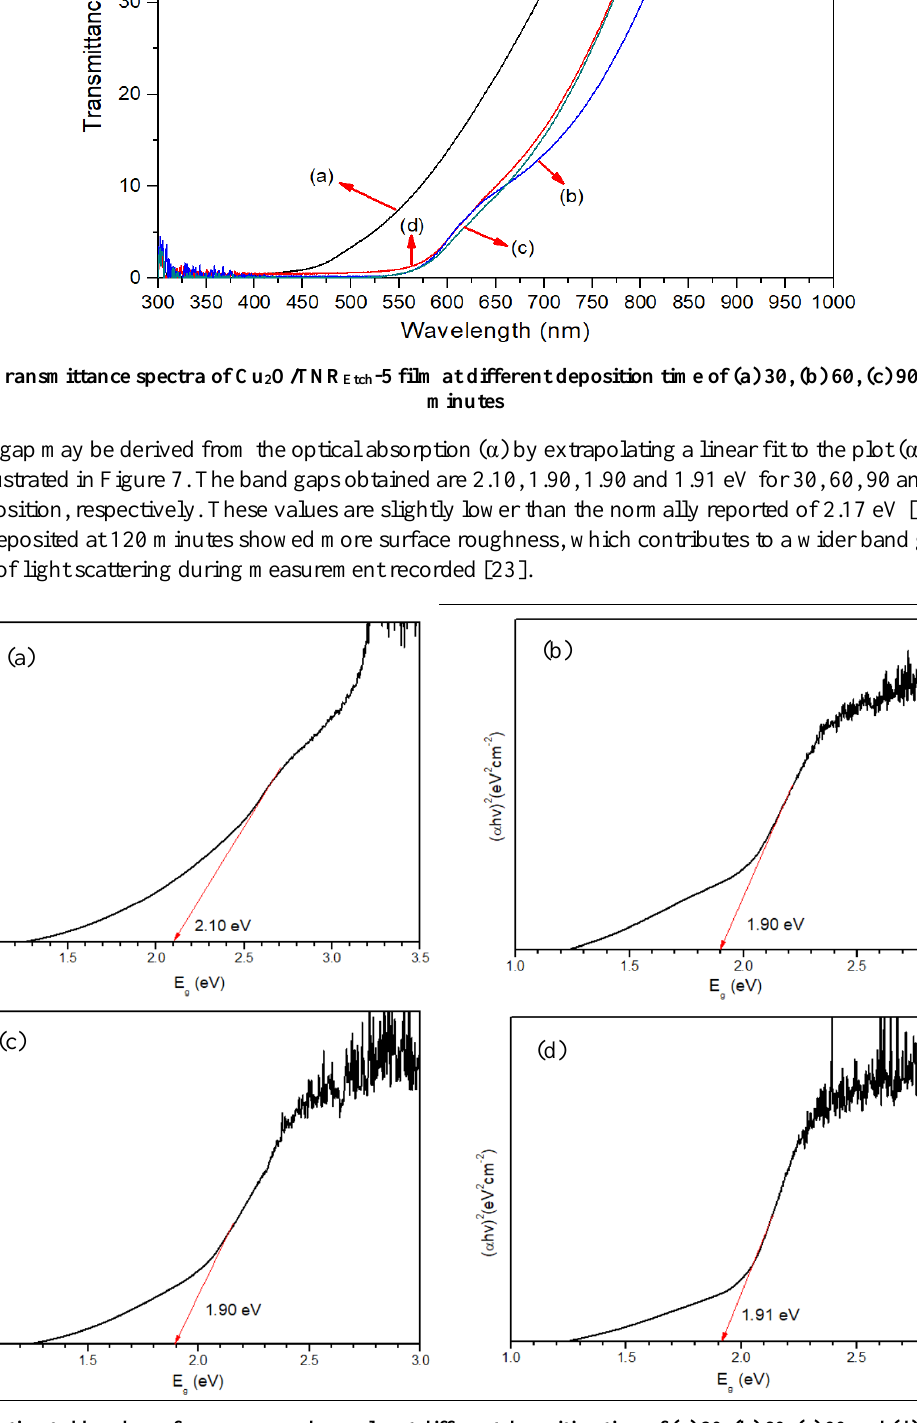
Figure 7. Estimated band gap for as-prepared samples at different deposition time of (a) 30, (b) 60, (c) 90 and (d) 120